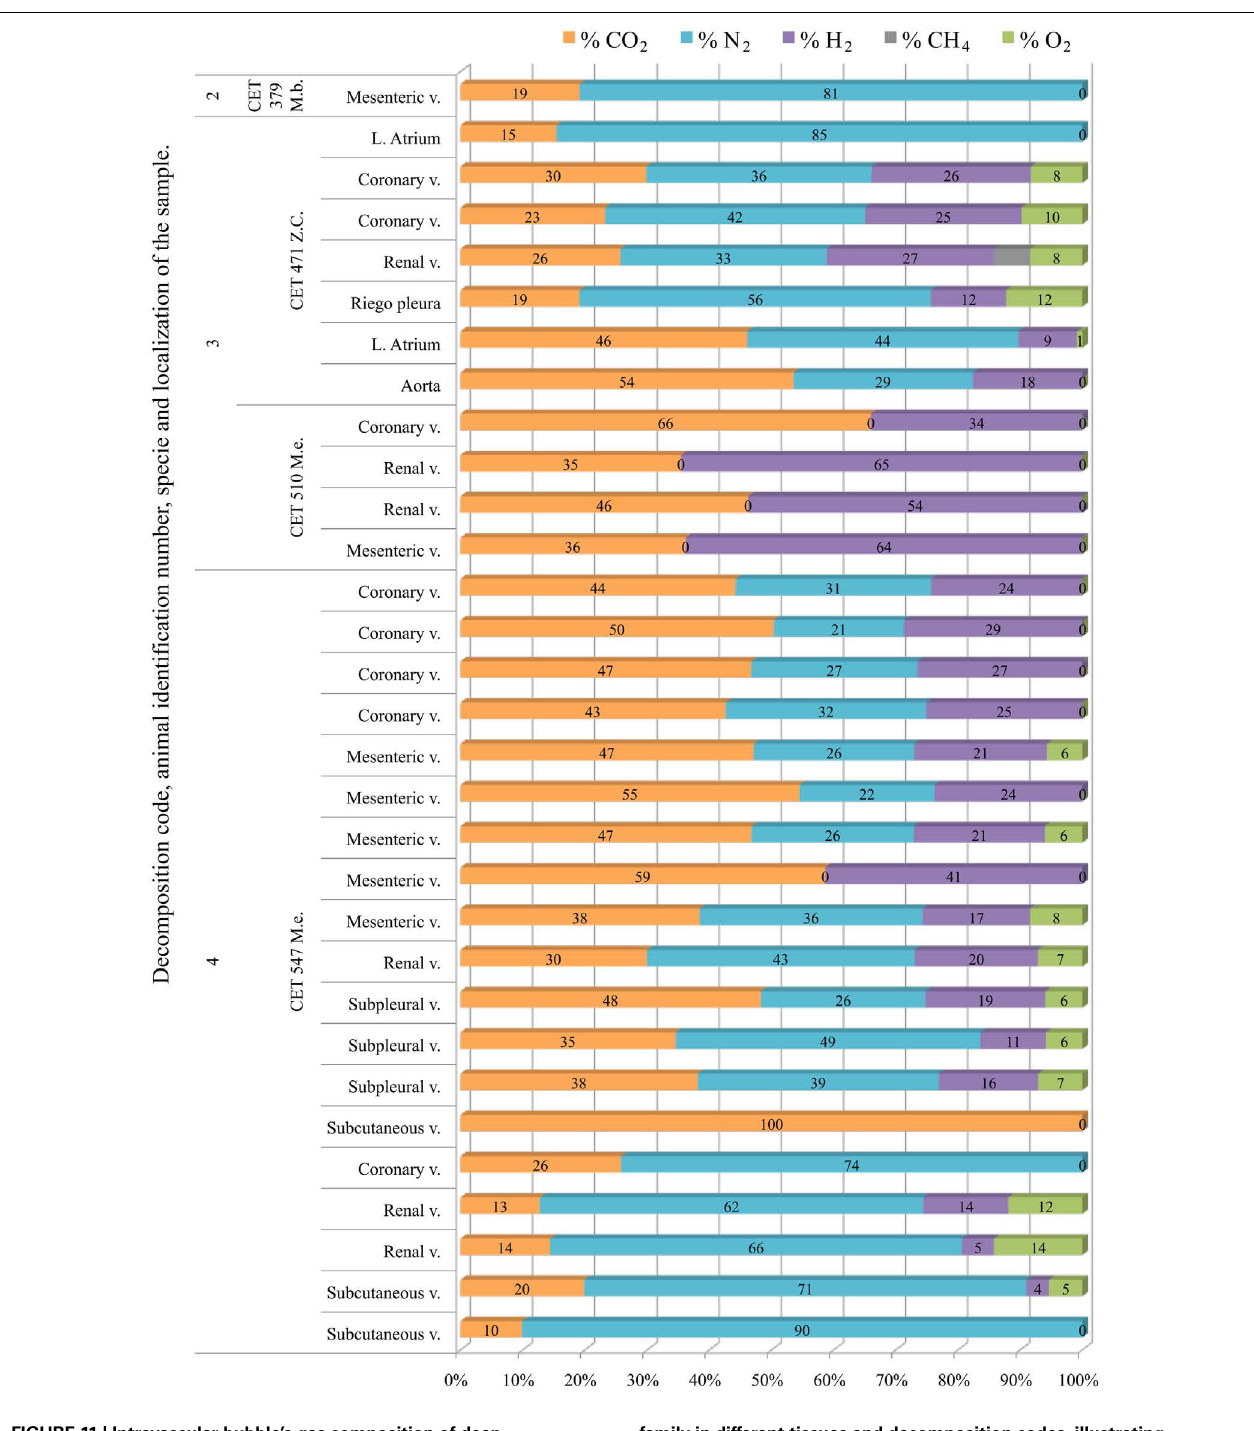
FIGURE 11 | Intravascular bubble’s gas composition of deep diving animals belonging to Ziphiidae (M.b., Mesoplodon bidens ; Z.c., Ziphius cavirostris ; M.e., Mesoplodon europaeus )